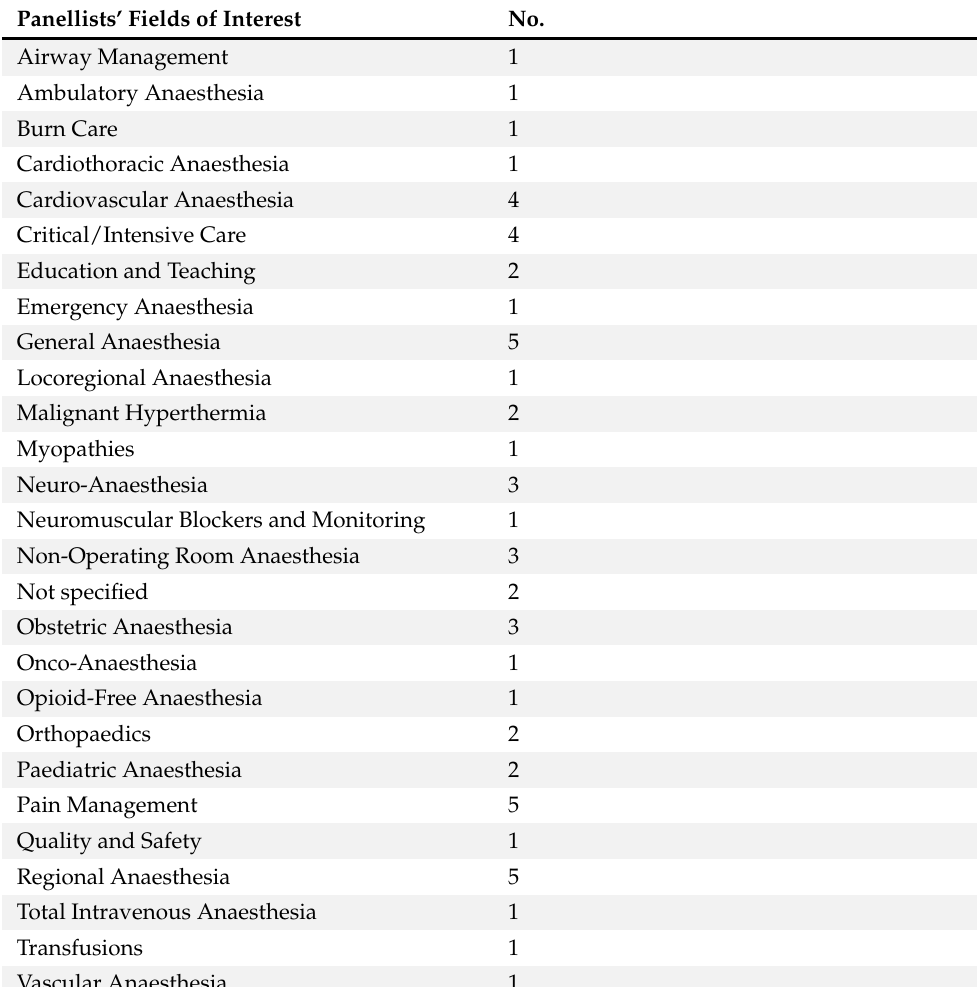
Table A1. Panellists’ Fields of